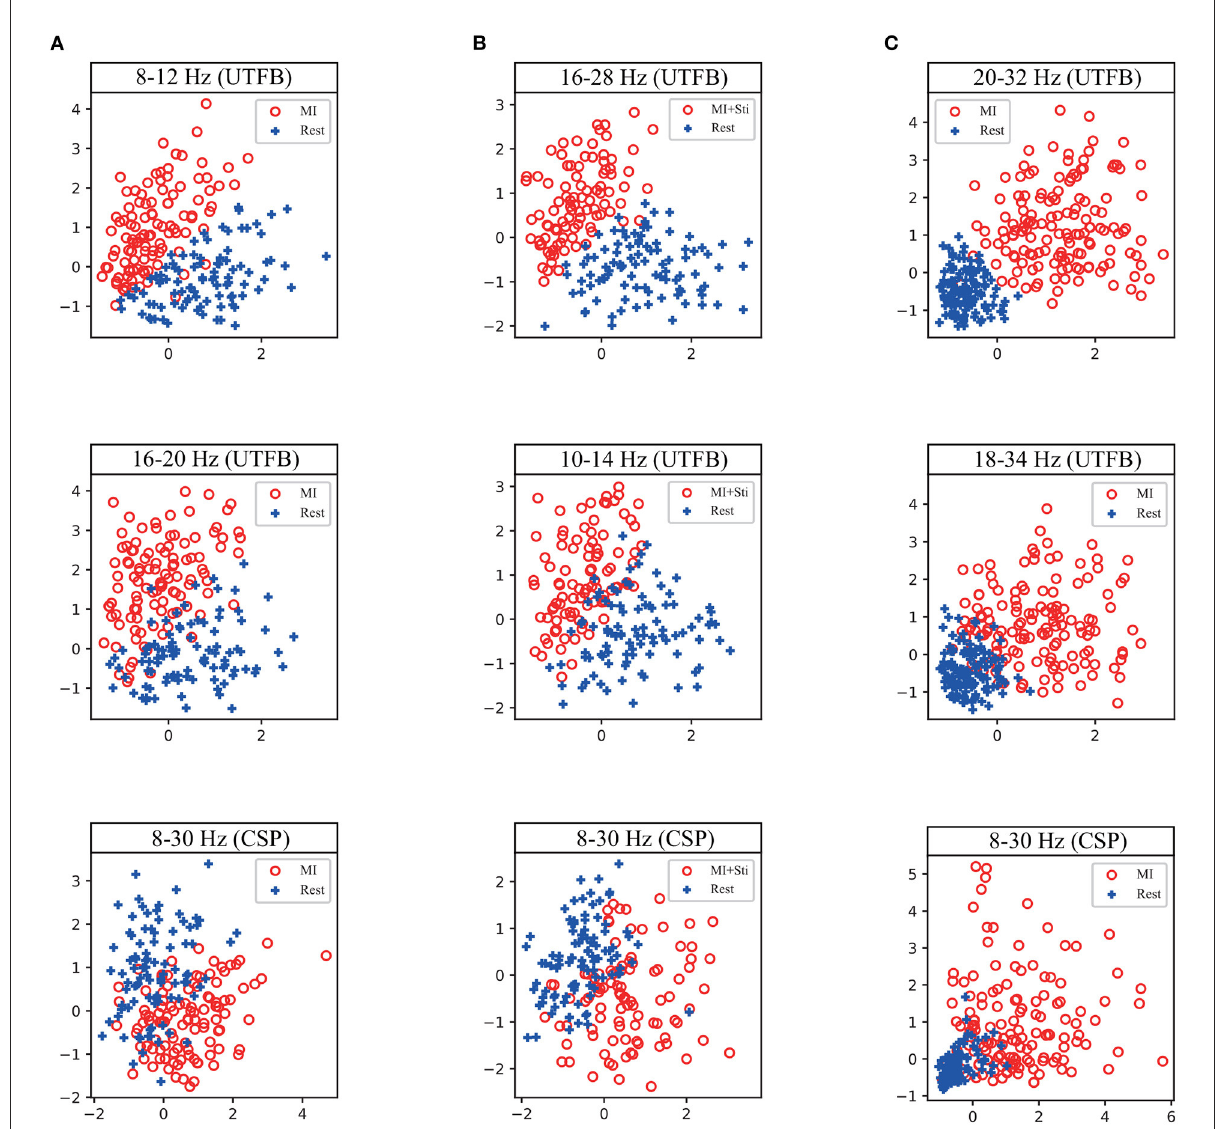
FIGURE9 2D feature distribution of each selected sub-band corresponding to the first and second coefficient in Figure 8 from a typical subject. (A) the subject A09 from in-house dataset without stimulation. (B) the subject A09 from in-house dataset with stimulation. (C) the subject S07 from BCI competition dataset